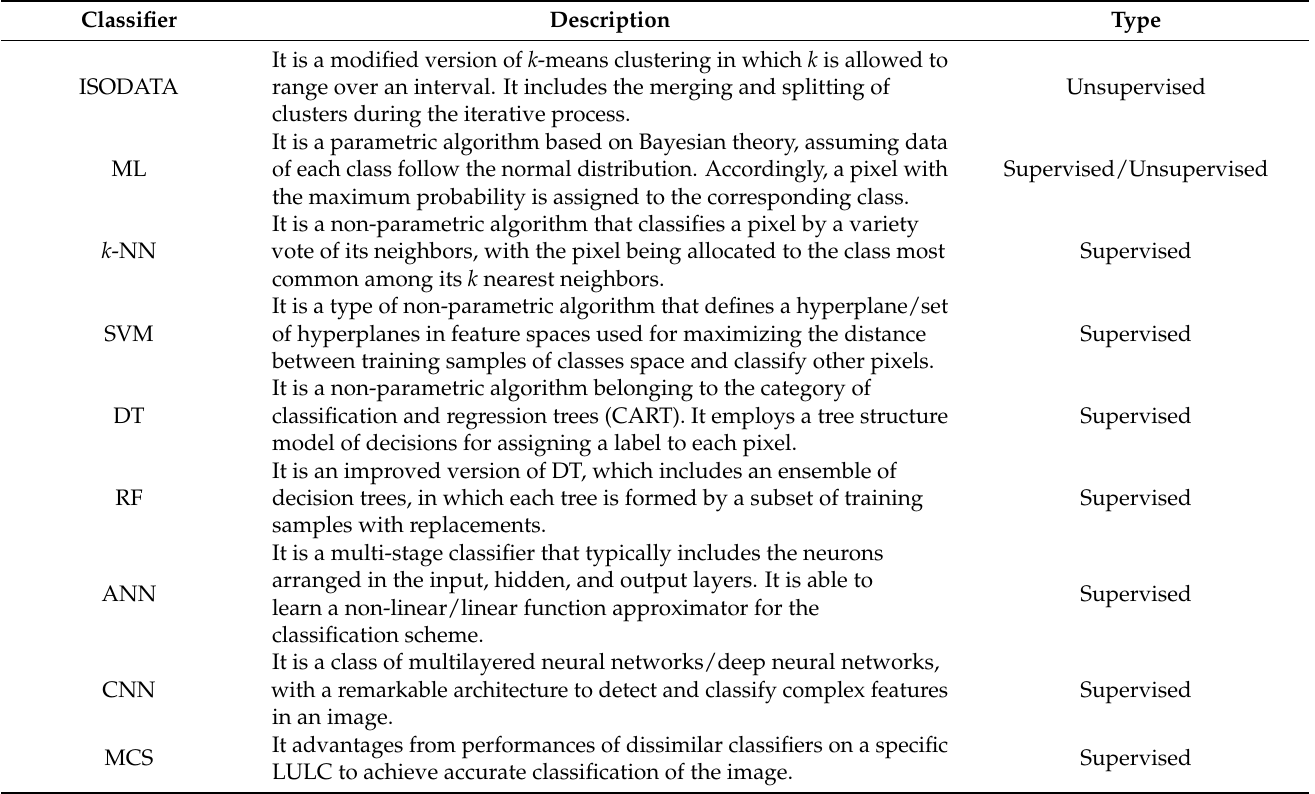
Table A1. Characteristics of the mostly used classifiers for wetland classification in Canada using RS data.